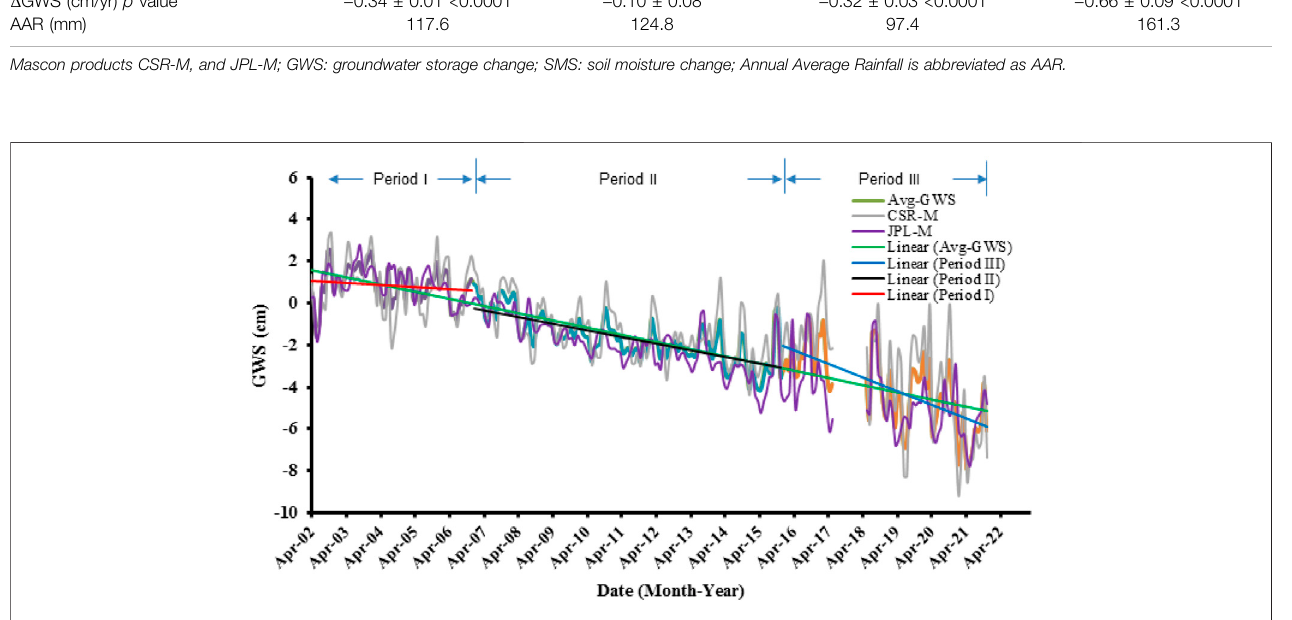
FIGURE 7 | Time series and averaging of Δ GWS from JPL-M and CSR-M mascon products across the study area over the investigated time.